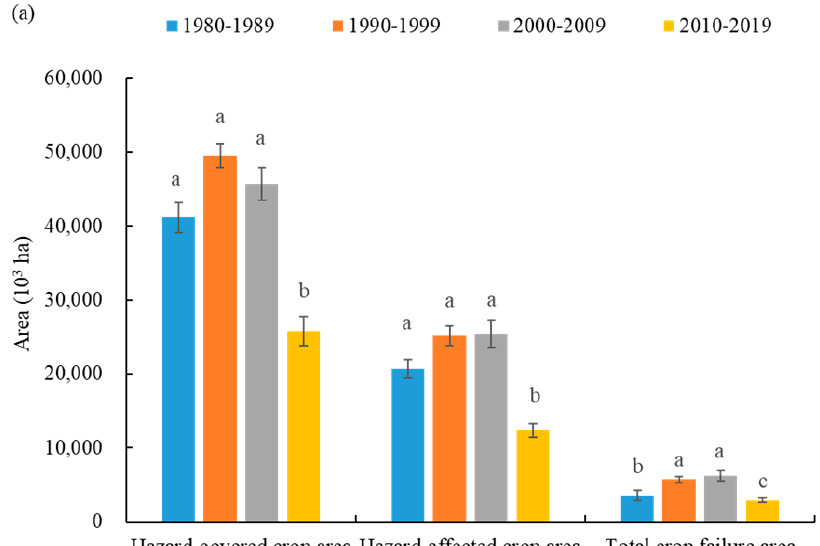
Figure 6. Yield in Inner Mongolia Autonomous Region from 1980 to 2019, and a comparison with the national average.